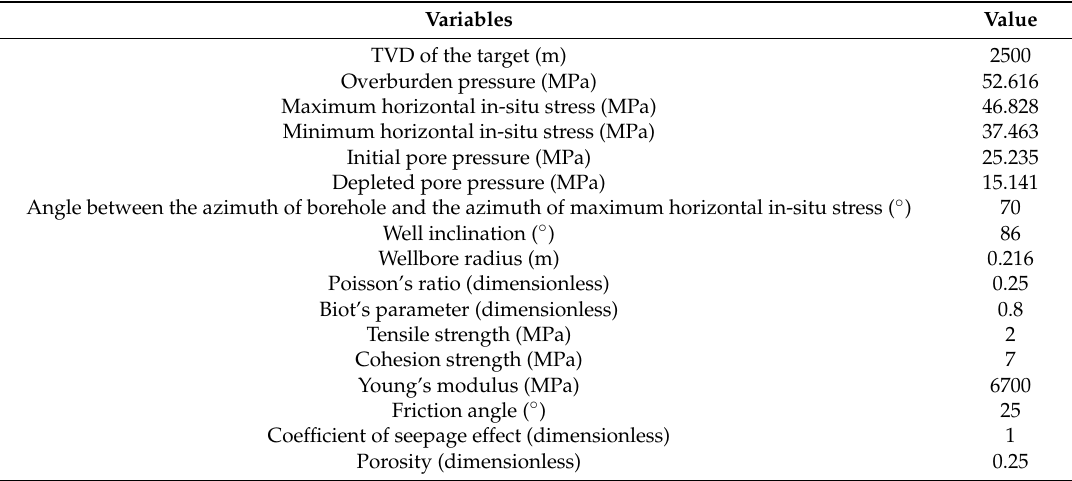
Table 1. Input data for